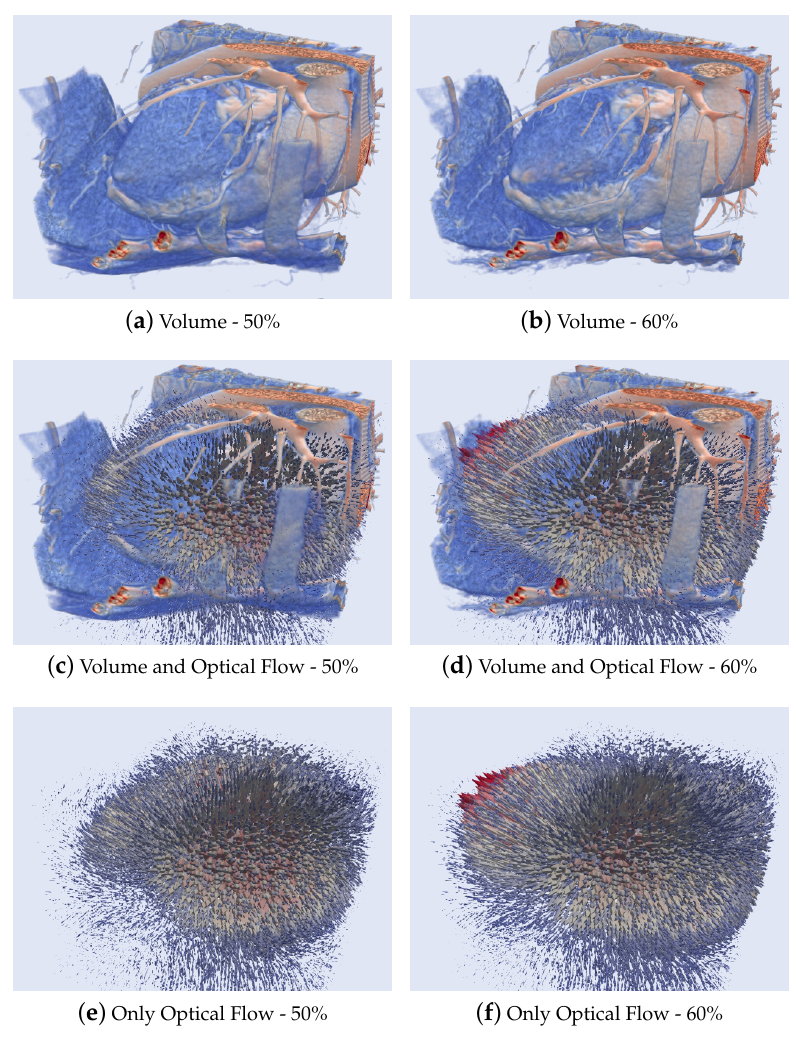
Figure 15. Results of 3D Optical Flow of a segmented cardiac CT volume computed at phases